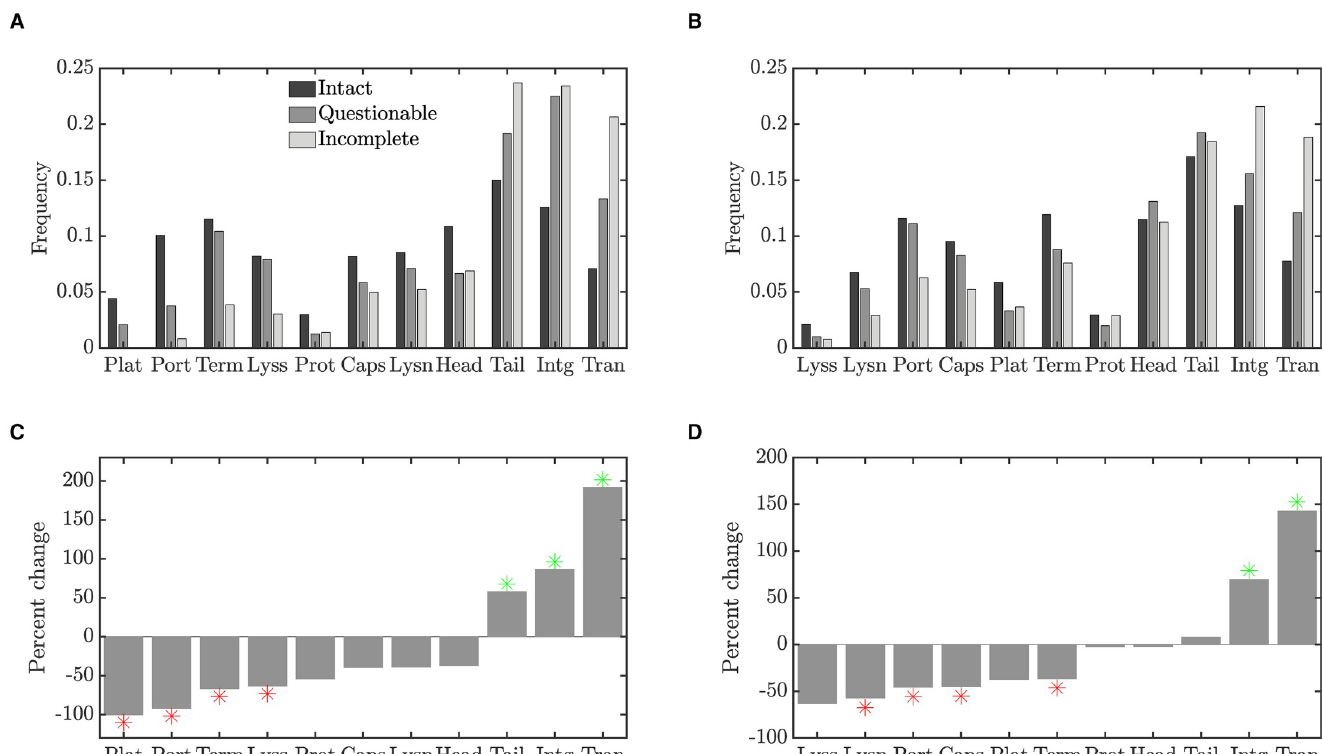
Fig 1. Changes in prophage gene frequencies, for intact, questionable and incomplete prophages. (A) The frequency of each gene class identified in Table 1 in prophages from Data Set 1 [13], for prophages identified as intact, questionable or incomplete. Gene classes that constituted less than 1% of the data have been excluded. Gene classes are ordered by the percent change in frequency (degree to which they are enriched in incomplete prophages, see panel C). (B) Gene frequencies as in panel A, but for Data Set 2 [16]. (C) Percent change in gene frequency in Data Set 1; the frequency of each gene class in incomplete prophages is compared to the baseline frequency of that class in intact prophages. Frequencies that were significantly lower (red) or higher (green) than expected by chance with a two-sided 5% significance threshold are indicated by stars. Thus red stars indicate gene classes that are preferentially lost, while green stars indicate classes that are enriched in short prophages. (D) Percent change in gene frequency for Data Set 2.